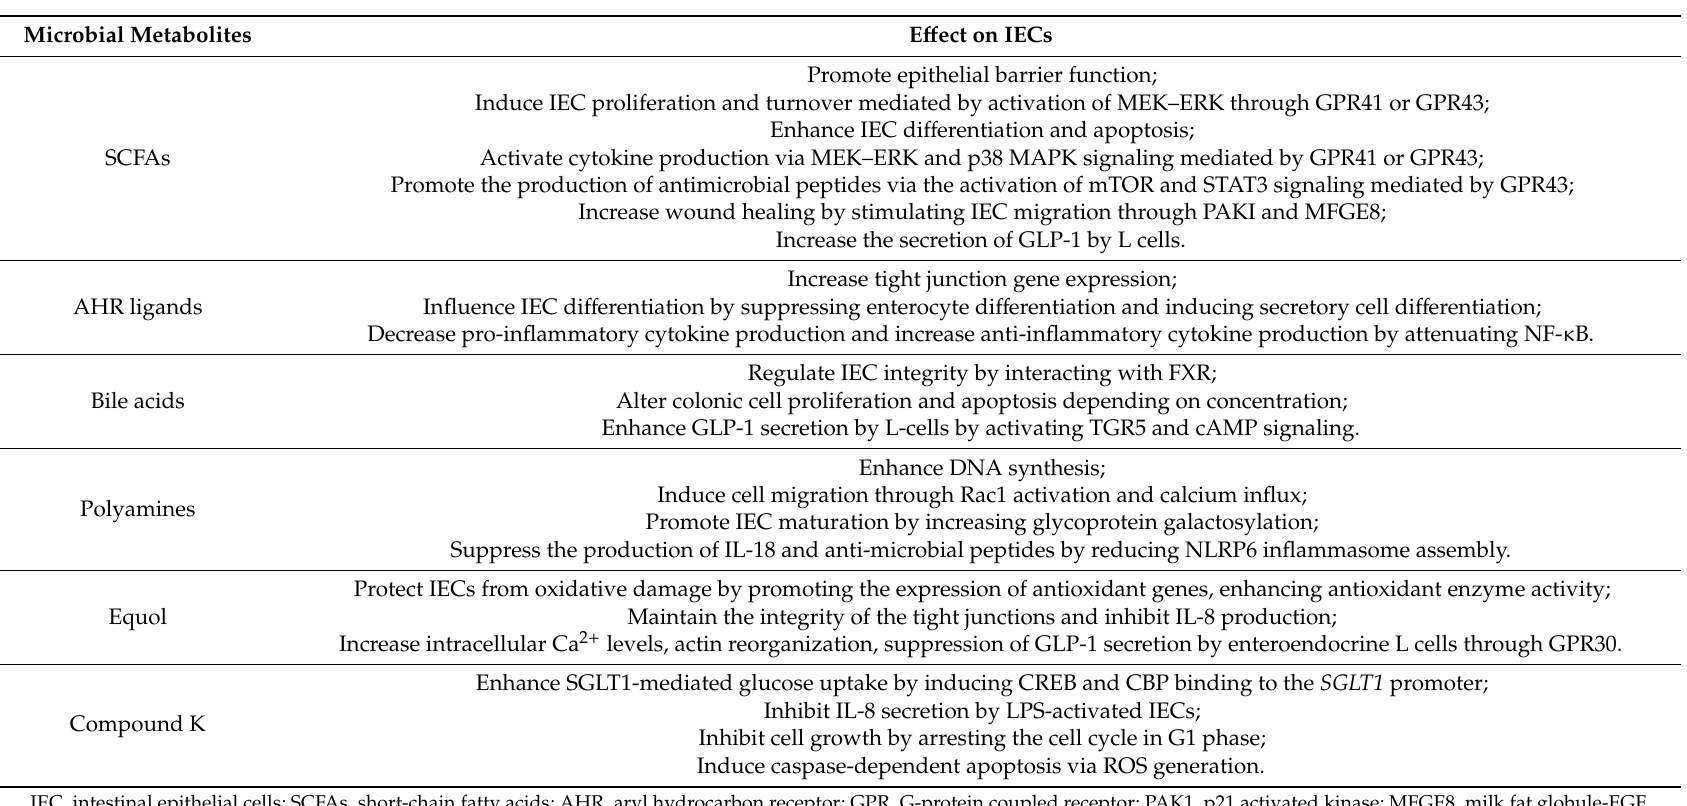
Table 1. The e ff ect of microbial metabolites on